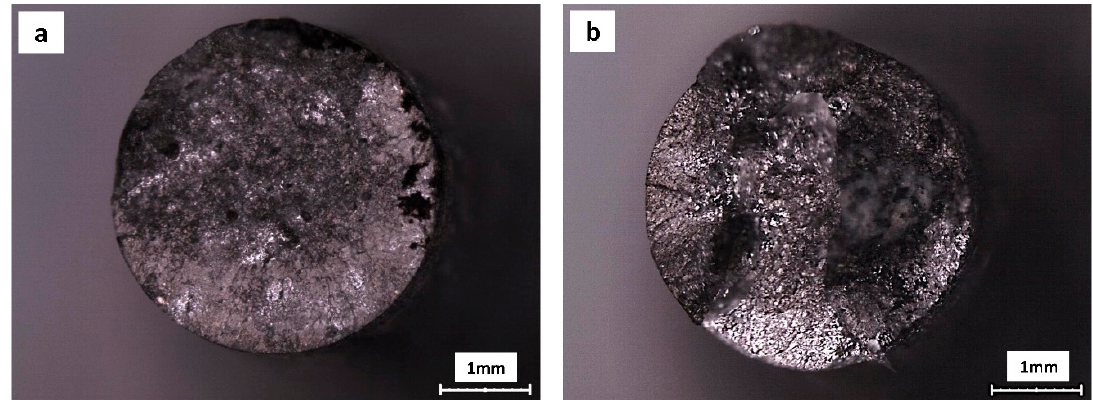
Figure 6. The typical fracture surface obtained after SSRT analysis at a strain rate of 2.5 × 10 − 5 s − 1 in PBS solution: ( a) Mg-5Zn-1Nd and ( b ) Mg-5Zn-2Nd.